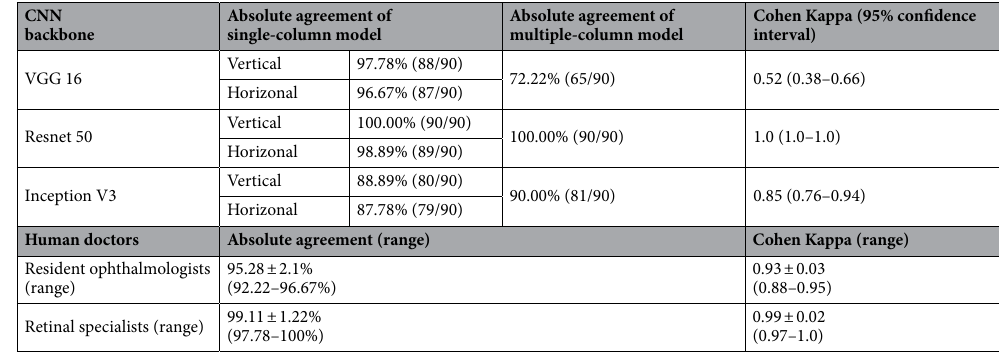
Table 3. Absolute agreement and intergrader agreement of the deep learning models, retinal specialists, and resident ophthalmologists. CNN convolutional neural network. (No. of correct diagnosis/no. of test set). Results of human doctor is given as mean ± standard deviation (four residents and five retinal specialists). The Cohen κ statistic was evaluated as follows: 0.21 to 0.40 indicated fair agreement; 0.41 to 0.60, moderate agreement; 0.61 to 0.80, substantial agreement; and 0.81 to 1.0, near-perfect